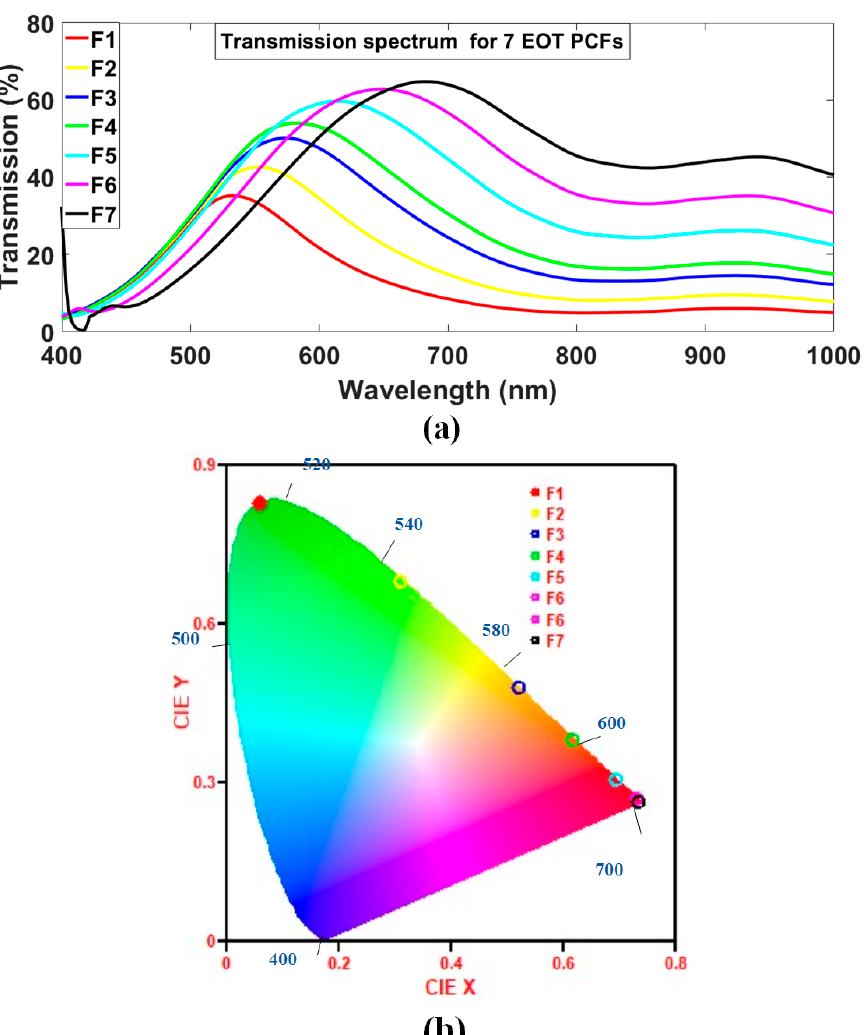
Figure 5. ( a ) Calculated transmission spectrum obtained for 7 EOT PCFs by changing the width W1, W2 from 55 to 95 nm and length L1, L2 from 190 to 250 symmetrically. ( b ) Seven EOT PCFs chromaticity diagram of CIE 1931 showing color change when length and width of the X-shaped nanostructure changed